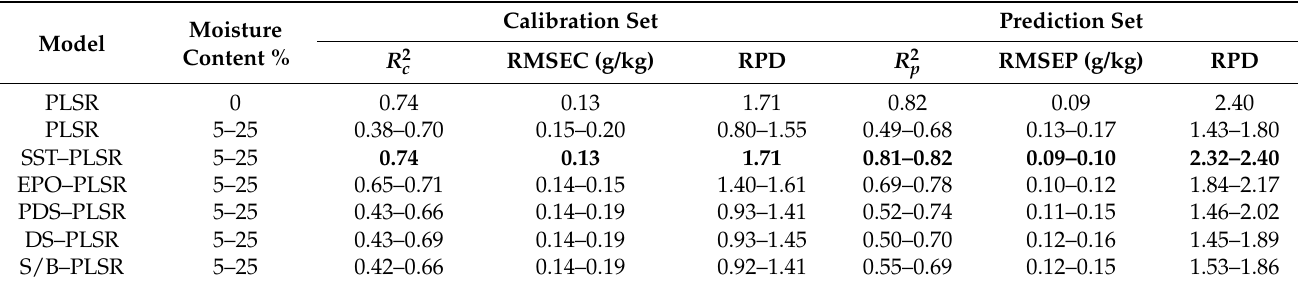
Table 2. TN prediction results of PLSR model under dry soil spectra and corrected PLSR model under wet soil